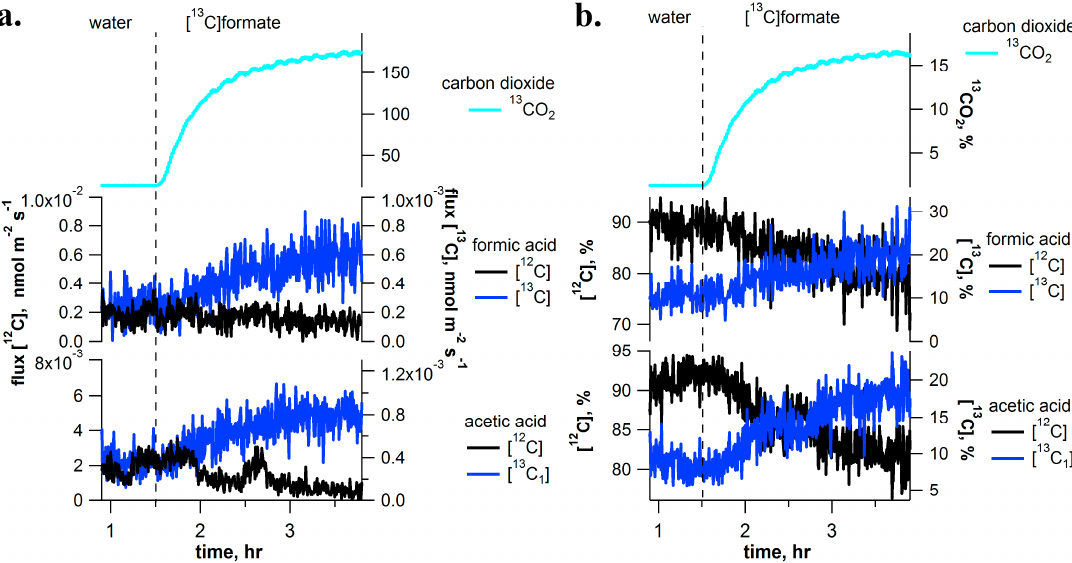
Figure 3. Example [ 13 C]formate labeling experiment on a detached branch of I. edulis showing real-time [ 13 C]labeling and unlabeling dynamics of C 1 and C 2 volatile metabolites using PTR-MS (absolute emissions in ( a ) and relative emissions in ( b )). 13 CO 2 branch emission of the dynamic headspace atmosphere are also shown based on cavity ring down spectrometry (CRDS). The vertical dashed line indicates a rapid change of solutions delivered to the transpiration stream (i.e., water to [ 13 C]formate). Note, despite a strong labeling of CO 2 emissions and a detectable labeling of formic and acetic acid emissions, significant labeling of methanol and formaldehyde emissions was not observed (data not